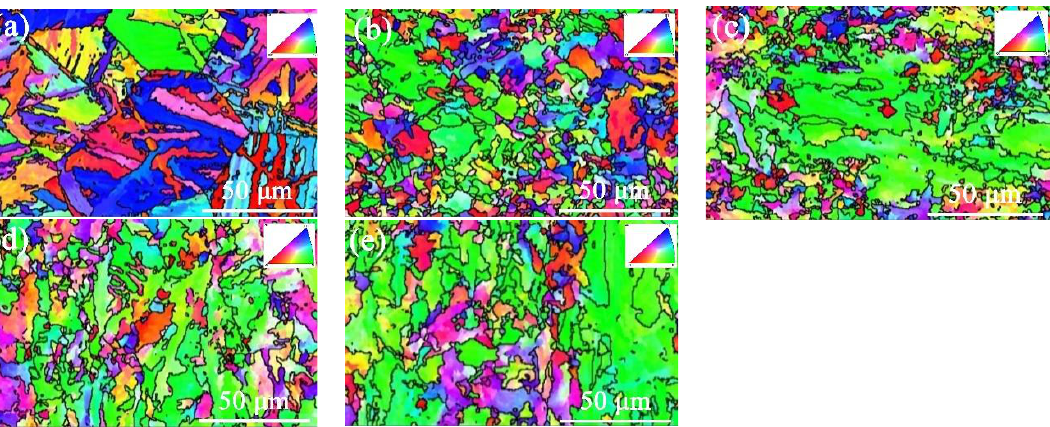
Figure 4. IPF images of actual welded joints: ( a ) CGHAZ; ( b ) FGHAZ; ( c ) ICHAZ; ( d ) SCHAZ; ( e ) base metal.